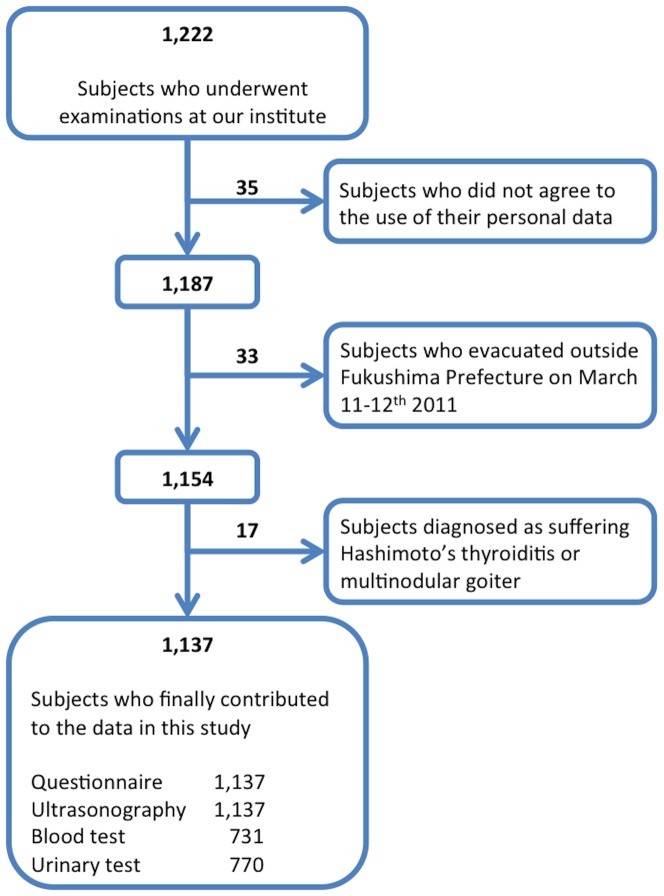
Sample sifting processes towards analyses.